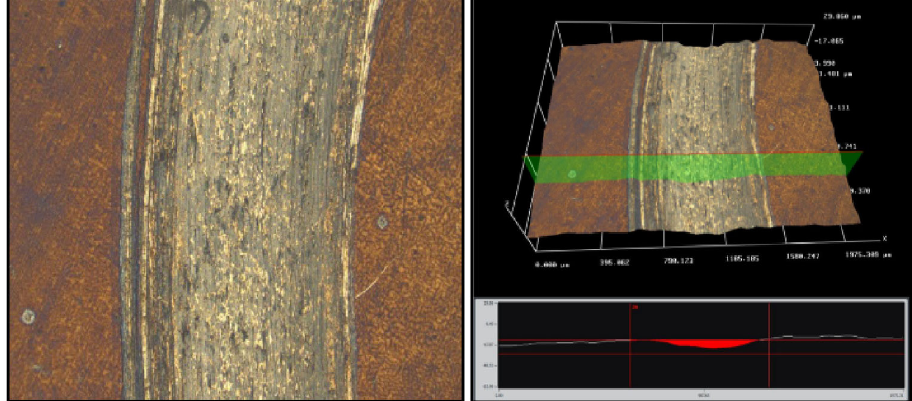
Fig. 1 Cross-sectional images of the wear marks observed using a 3D profile